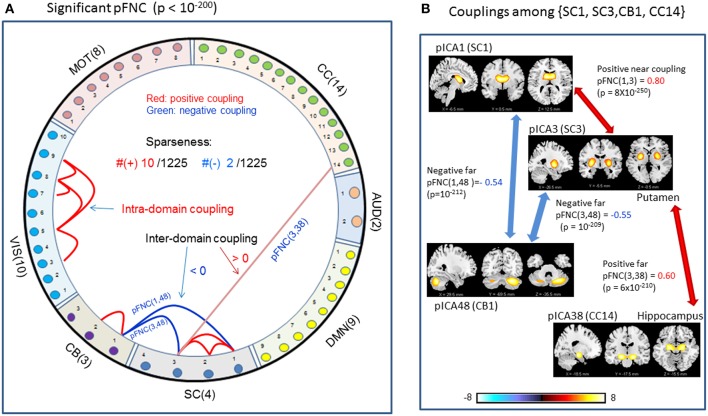
Illustrations of the most significant couplings in pFNC< (p < 10−200). (A) There are nine (9) intra-domain positive couplings (near, in bright red color) and one (1) inter-domain positive coupling (far, in soft red color), and two (2) inter-domain negative couplings (far, in blue color). (B) Features of the two negative interdomain couplings pFNC(1,48) and pFNC(3, 48).